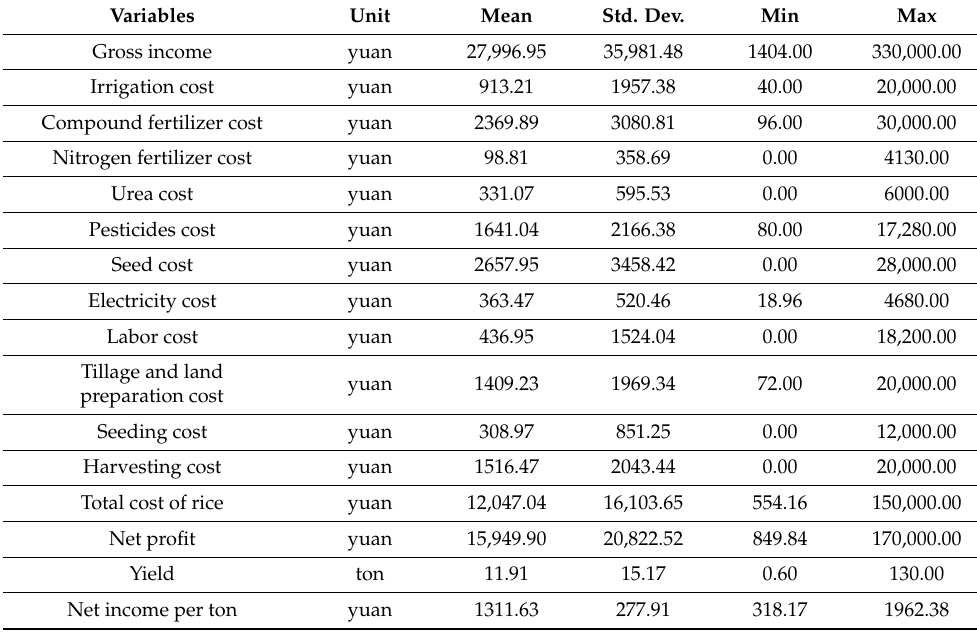
Table A1. Rice cost and revenue data for sample